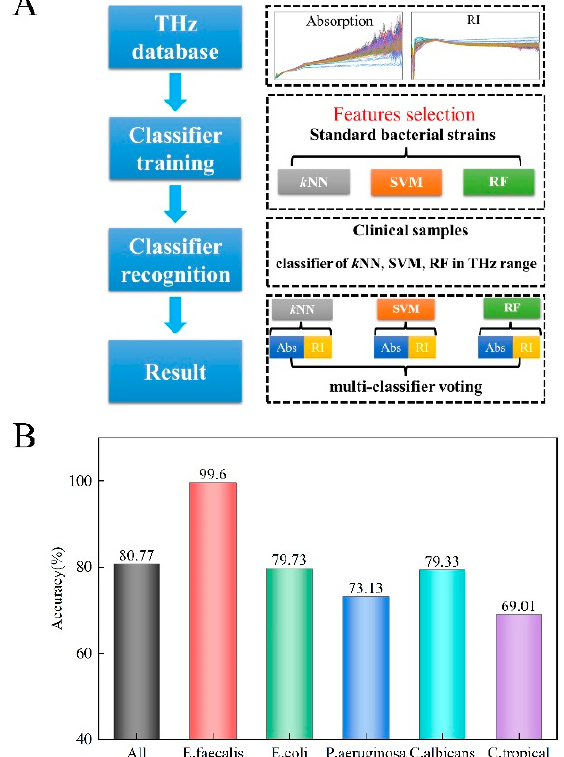
Figure 4. ( A ) The proposed automated recognition workflow for constructing the THz database of common microorganisms. ( B ) Discrimination function filter of the automatic recognition method is based on the multi-classifier voting scheme for clinical strain diagnosis.